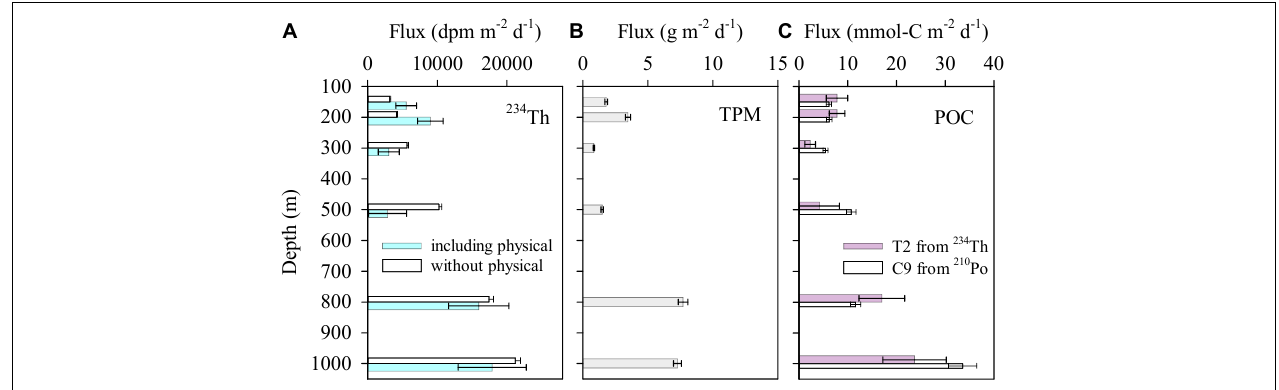
FIGURE 4 | Fluxes of 234 Th and particles on the northeastern shelf of the South China Sea (SCS), including (A) 234 Th fluxes ignoring physical processes and considering advection and diffusion, (B) 234 Th-derived TPM fluxes including physical processes, and (C) POC fluxes estimated from the 234 Th– 238 U method (this study) and the 210 Po– 210 Pb method (Yang et al.,